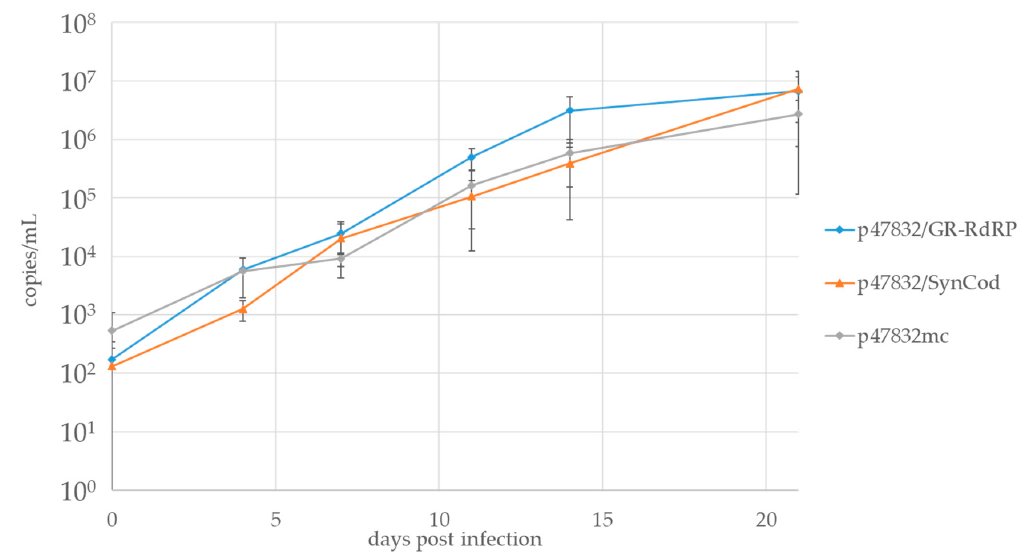
Figure 5. Comparison of viral replication kinetics of the generated infectious virus mutants p47832/SynCod and p47832/GR-RdRp with that of p47832mc. A549/D3 cells were infected with similar virus titers and the culture supernatants were analyzed using RT-qPCR at different time-points after infection. Data are means +/ − SD from two independent experiments. An unpaired, heteroscedastic Student’s t -test showed no significant differences between virus titers at the different time points (all values p > 0.05).